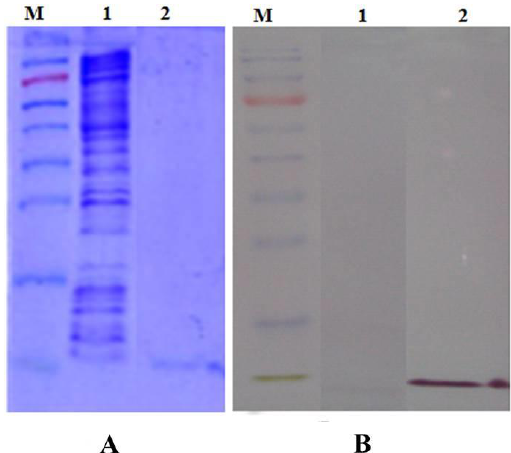
Fig. 3. SDS-PAGE and Western blot for purification of expressed protein with Ni-NTA column: (A) Purification of the expressed protein (1= Flow-through, 2= Elution, M= Protein marker); (B) Western blot showing the purified protein (1= Flow-through, 2= Elution, M= Protein marker).